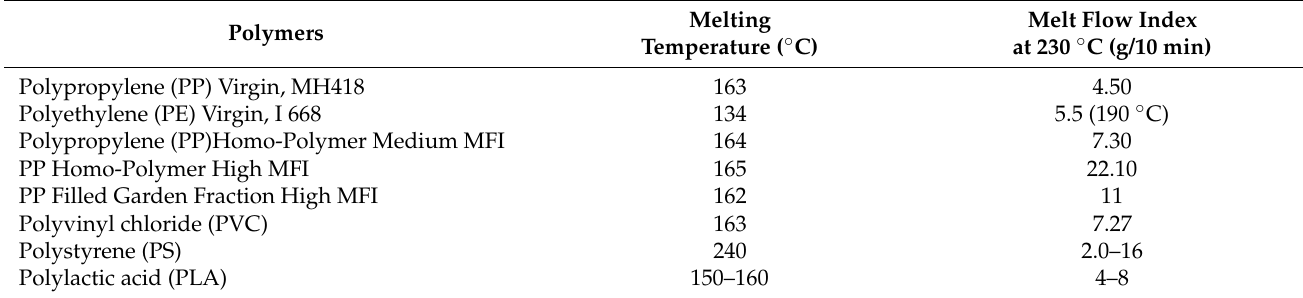
Table 1. The properties of virgin and fractionated reused polymers [27].